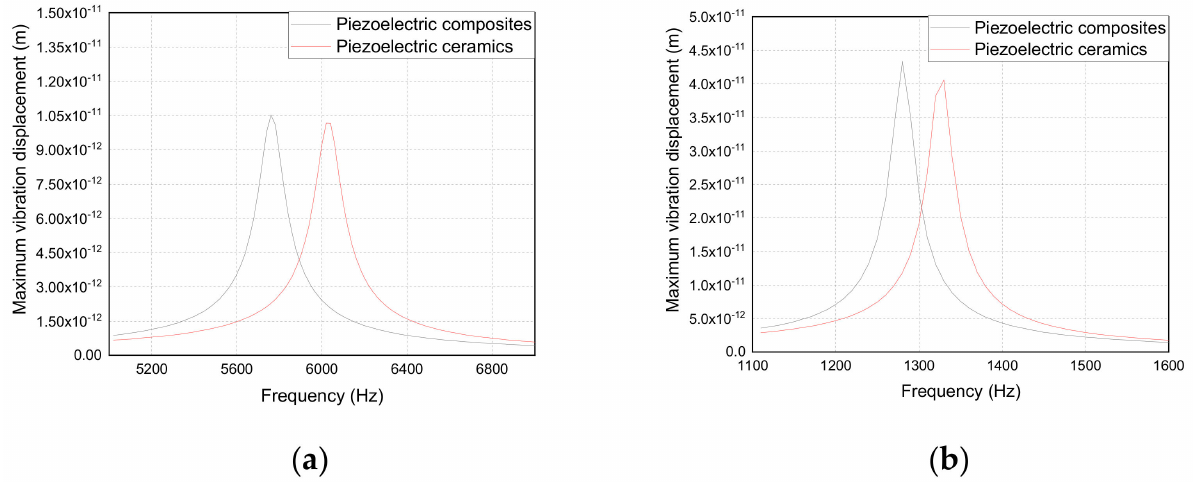
Figure 7. The vibration displacement curve of the trilaminar vibrator: ( a ) free boundary; ( b ) fixed